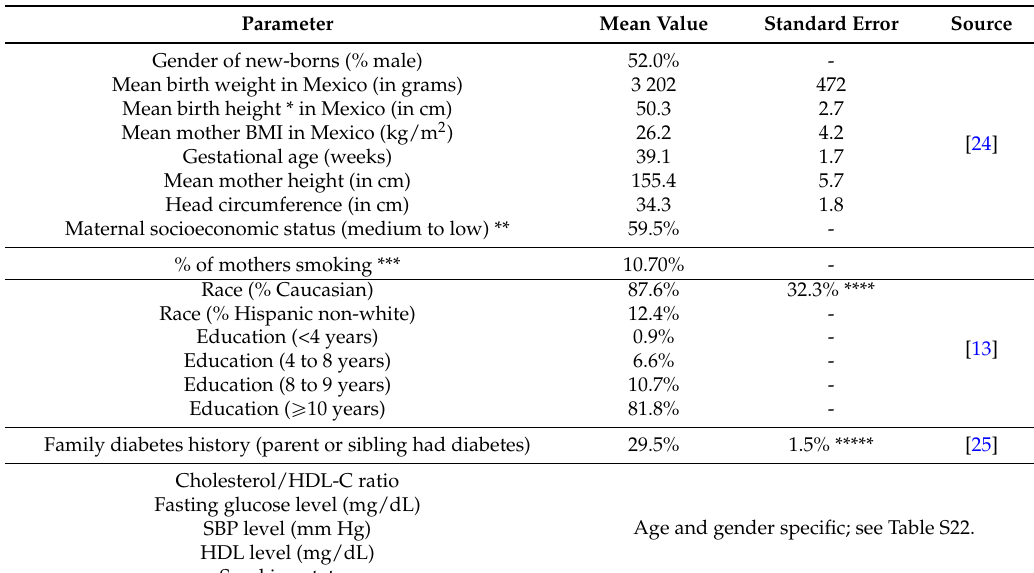
Table 1. Individual